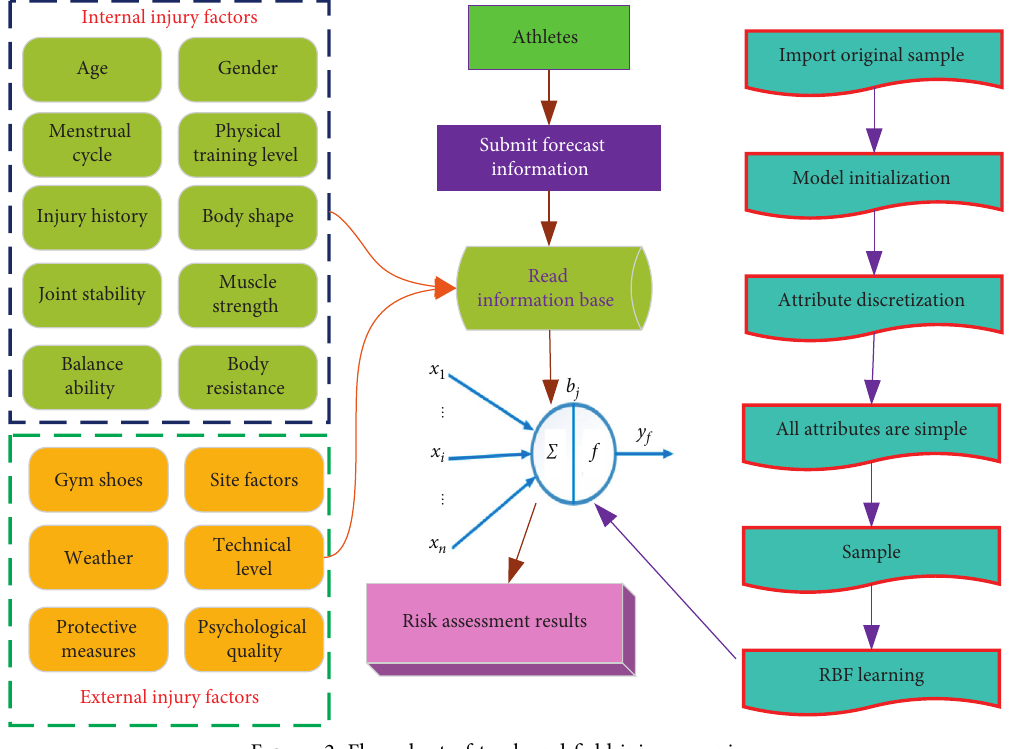
Figure 2: Flow chart of track and field injury warning.